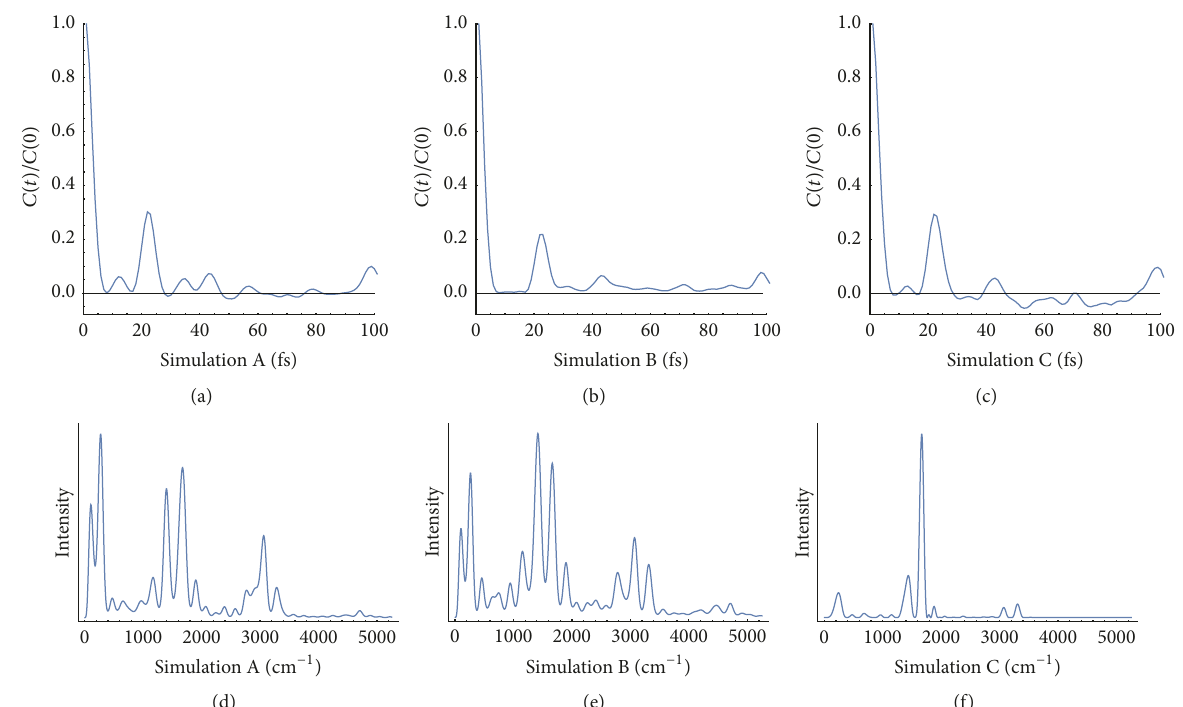
Figure 5: (a–c) Autocorrelation of the energy gap between first and second excited states for simulations A, B, and C. The correlation times for all three simulations is 8fs. (d–f) These plots show the active IR active modes that contribute to the modulation in the CI energies of the systems. Three distinct regions are visible in each plot. The low frequency torsional modes occur between 200 and 500 cm −1 , the C=C stretching modes occur between 1300 and 1800cm −1 , and the C-H stretching modes occur between 2800 and 3300 cm −1 .